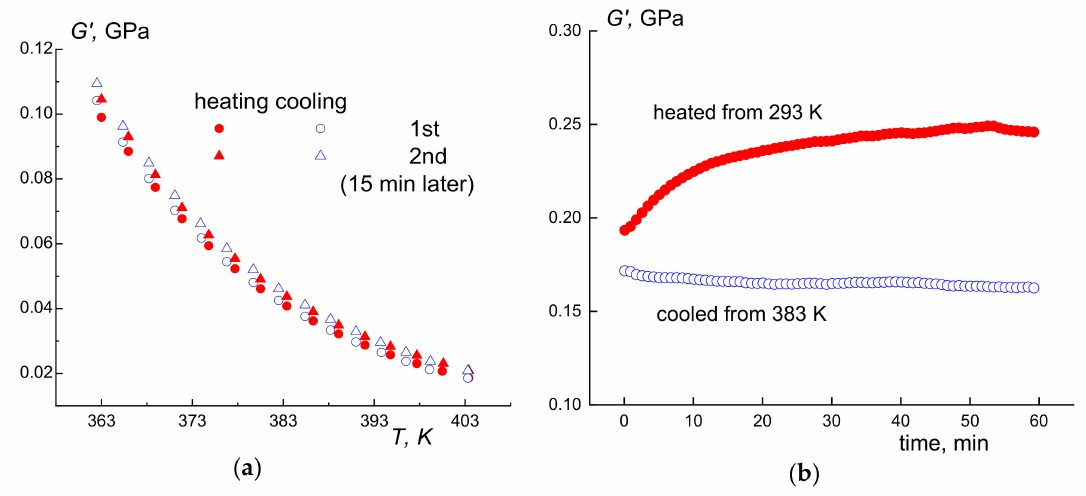
Figure 9. Dependences of the storage modulus, G’, of NB–CDD C7 copolymer on ( a ) temperature in two heating–cooling cycles at 5 K/min and ( b ) time at 349 K measured by oscillatory rheology at 1 Hz with 1% strain. The sample was preheated up to 383 K to erase the thermal